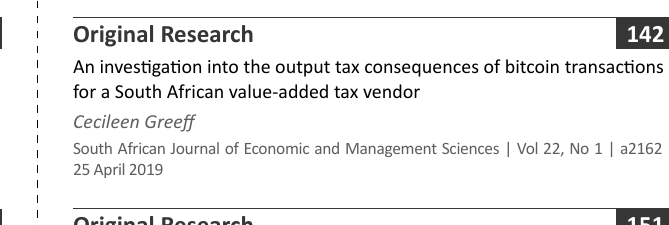
Knowledge exchange and ethnic networks of clustered small-scale enterprises in Africa: A case study of furniture cluster in Tanzania Yessica C.Y.